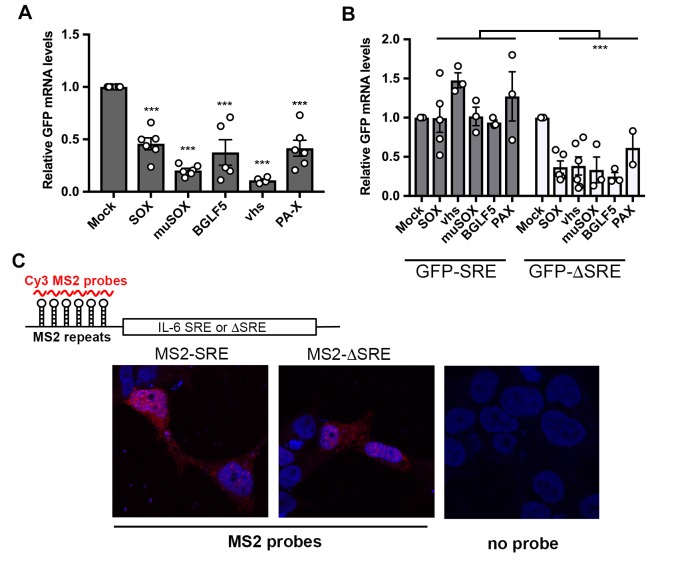
The IL-6-SRE broadly protects against multiple viral endonucleases.(A) 293T cells were transfected with empty vector (mock) or a plasmid expressing the indicated endonucleases along with a GFP reporter. After 24 h, total RNA was harvested and subjected RT-qPCR to measure GFP mRNA levels. Graphs here and afterwards display individual replicates as dots, together with the mean values (±SEM). Statistical significance was determined by the Student t test (* p<0.1; ** p<0.05; *** p<0.01). (B) 293T cells were co-transfected with the indicated endonuclease-expressing plasmid expressing together with a GFP-SRE or GFP-ΔSRE reporter. After 24 h, total RNA was harvested and subjected RT-qPCR to measure GFP mRNA levels. (C) Top: diagram showing the structure of the reporter mRNA containing MS2 repeats upstream of the SRE or ΔSRE fragment of the IL-6 3’UTR. Red lines denote the region detected by the MS2 probe. Bottom: 293T cells were transfected with the indicated MS2 reporters. 24h later, cells were fixed and processed for RNA FISH staining. Signals from the MS2 probes (red) and DAPI stained nuclei (blue) were detected by confocal microscopy.